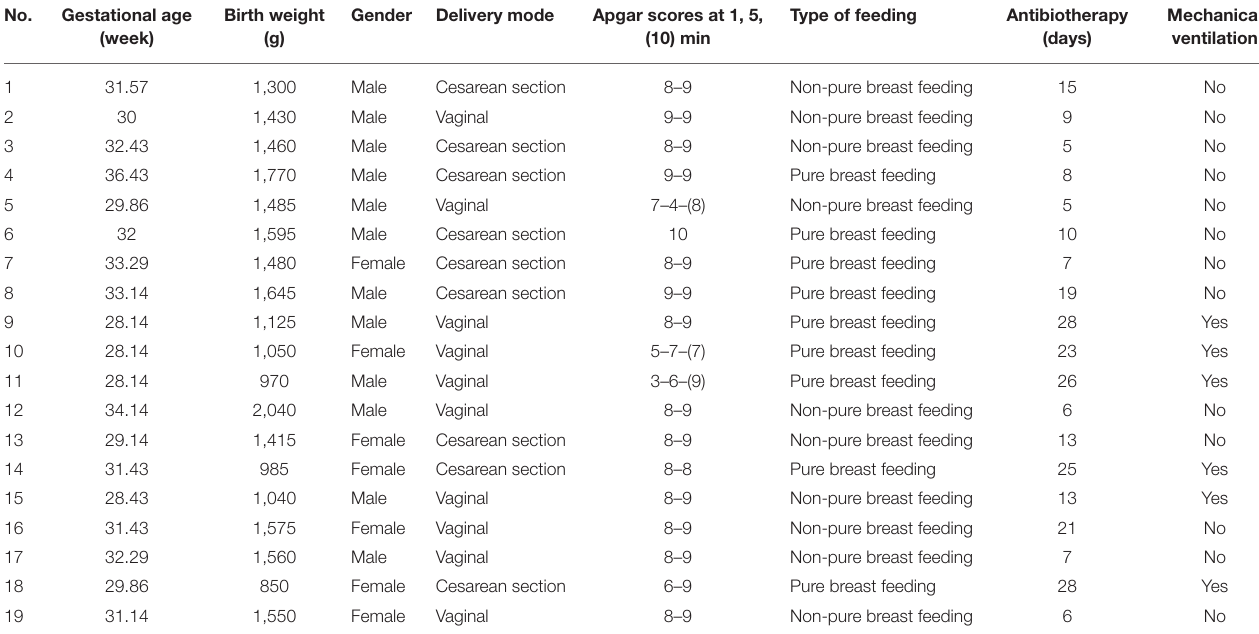
TABLE 1 | Demographic and clinical characteristics of the preterm infants in this study ( n = 19). No.